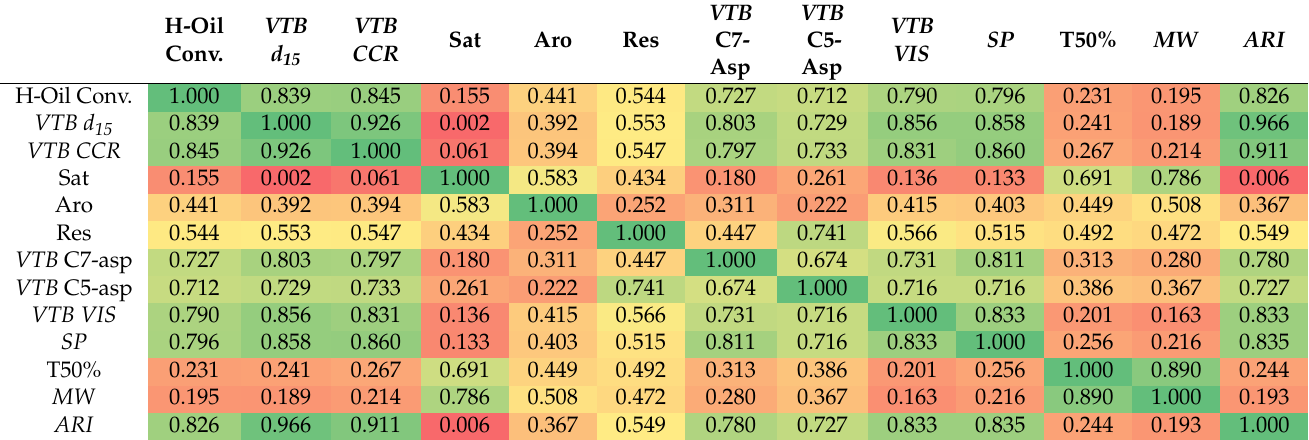
Table 7. The µ -values for the ICrA evaluation of relations between properties of the studied H-Oil VTB